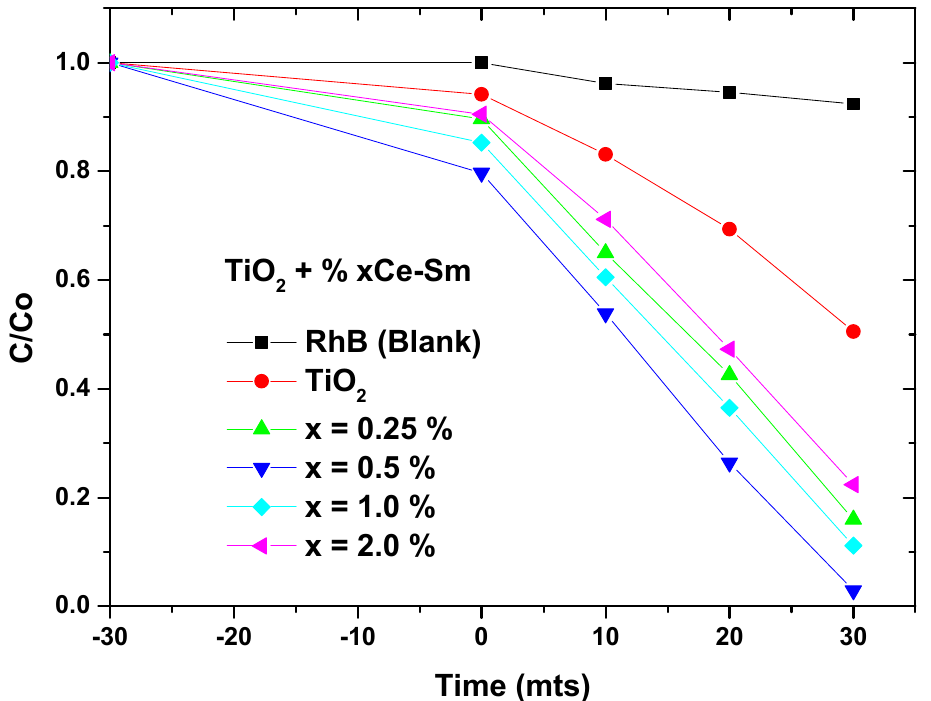
Figure 11. Degradation of RB dyes over time of Ce–Sm co-doped TiO 2 NPs ( x = 0.00, 0.25, 0.50, 1.00, and 2.00%).